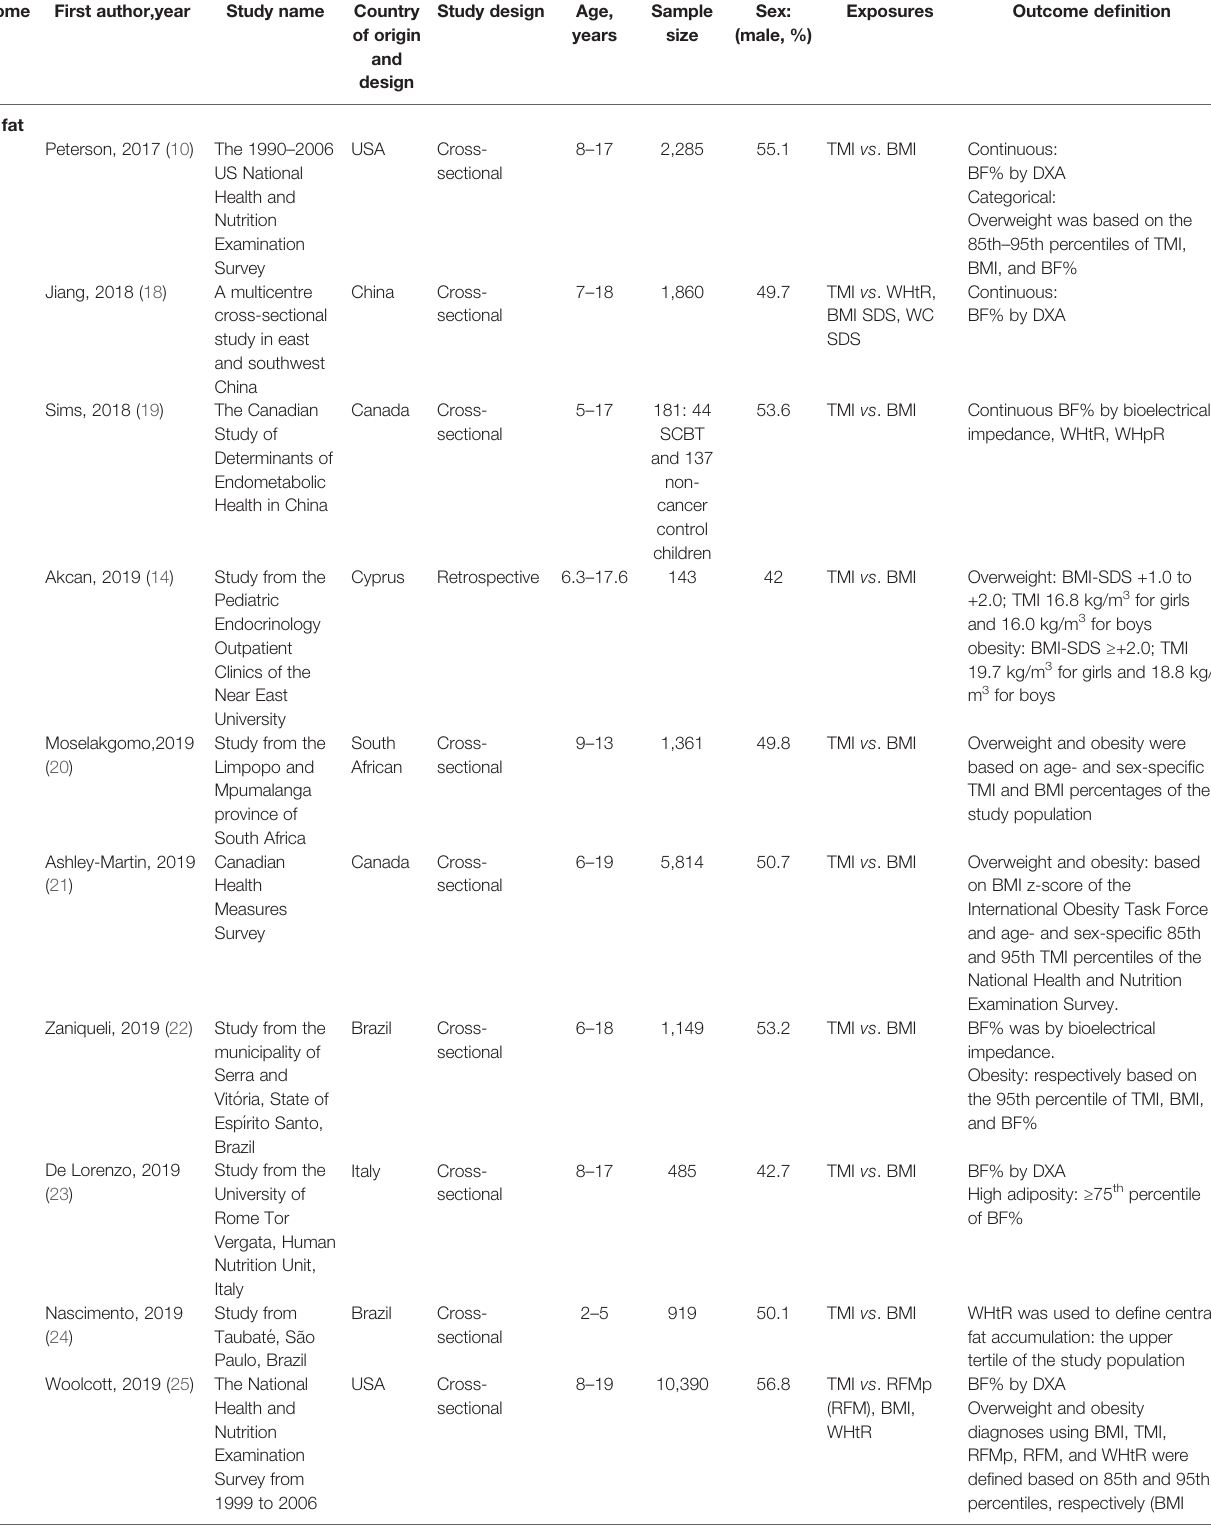
TABLE 1 | Study characteristics of the included